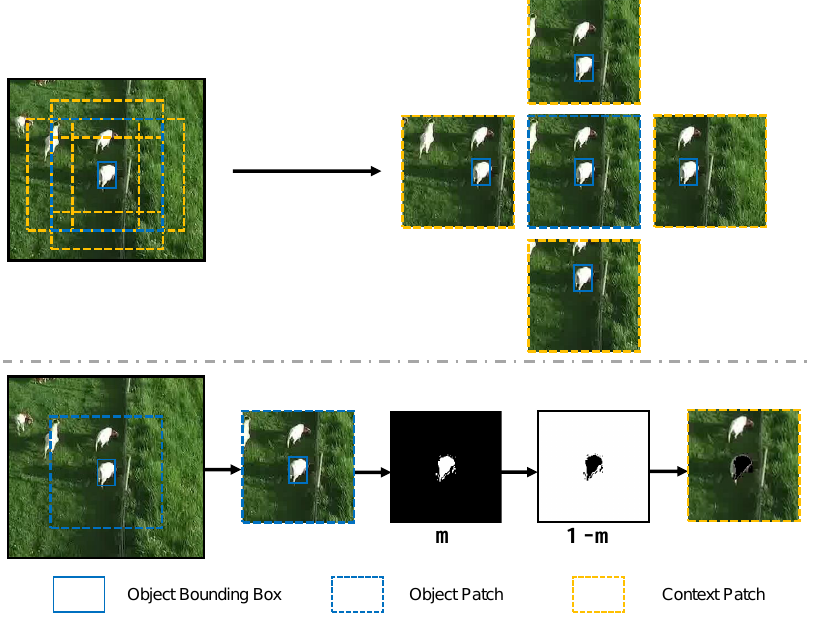
Figure 2. Different strategies of obtaining context patch. Top : traditional method. Bottom : our efficient